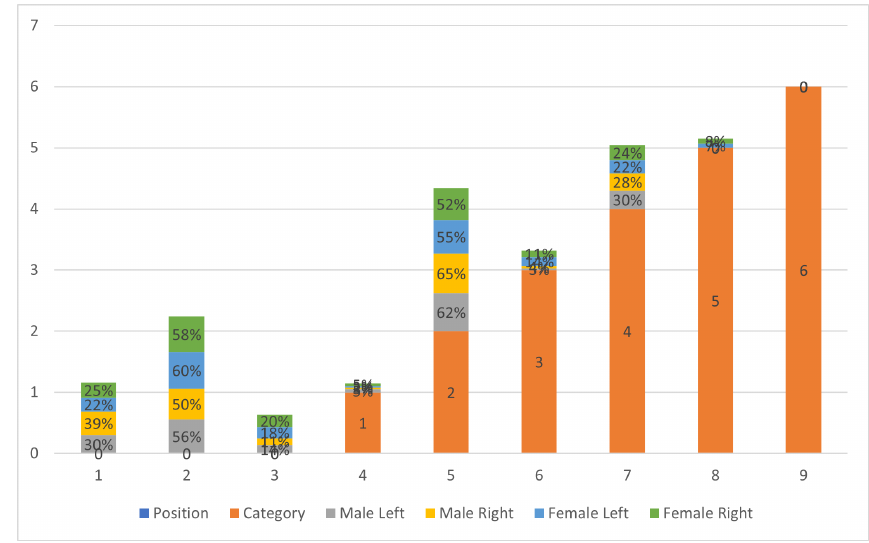
Figure 1. Graphic representation of the effect of ICT Solutions on total anthropogepainic GHG supply